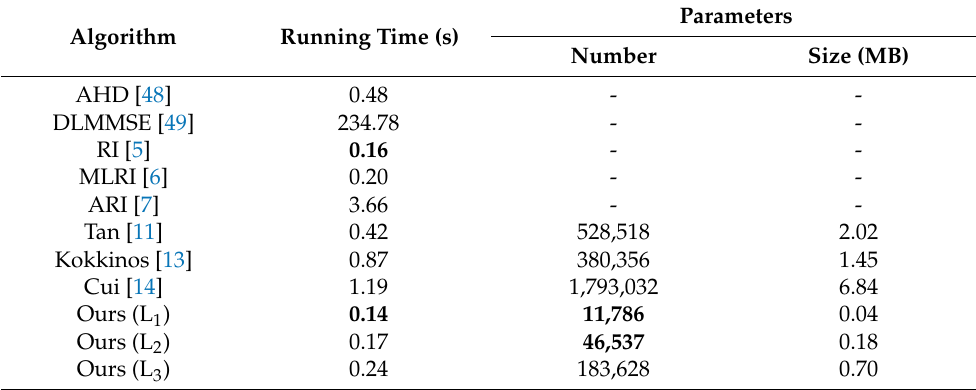
Table 4. The average running time of a 500 × 500 image in McMaster and the number and size (for double-precision floating-point format) of parameters for CNN-based models. The bolded two methods in each section are those that achieve better performance among all algorithms.